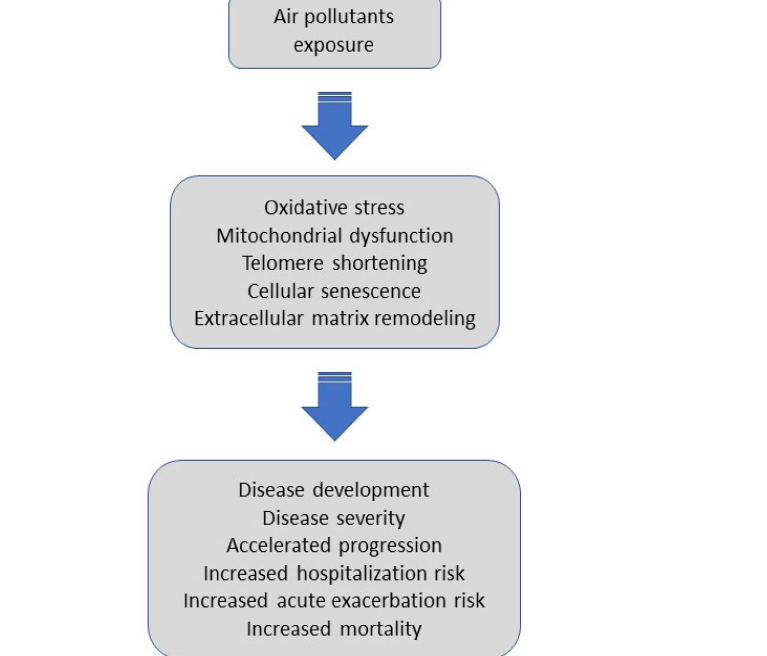
Figure 2. Potential mechanisms triggered by air pollutants and their impact on outcomes in IPF. Air pollutants exposure, via oxidative stress, mitochondrial dysfunction, telomere shortening, cellular senescence, and extracellular matrix remodeling might promote disease development, affect an individual’s disease severity, accelerate progression, trigger hospitalization or acute exacerbation, and increase overall mortality in patients with